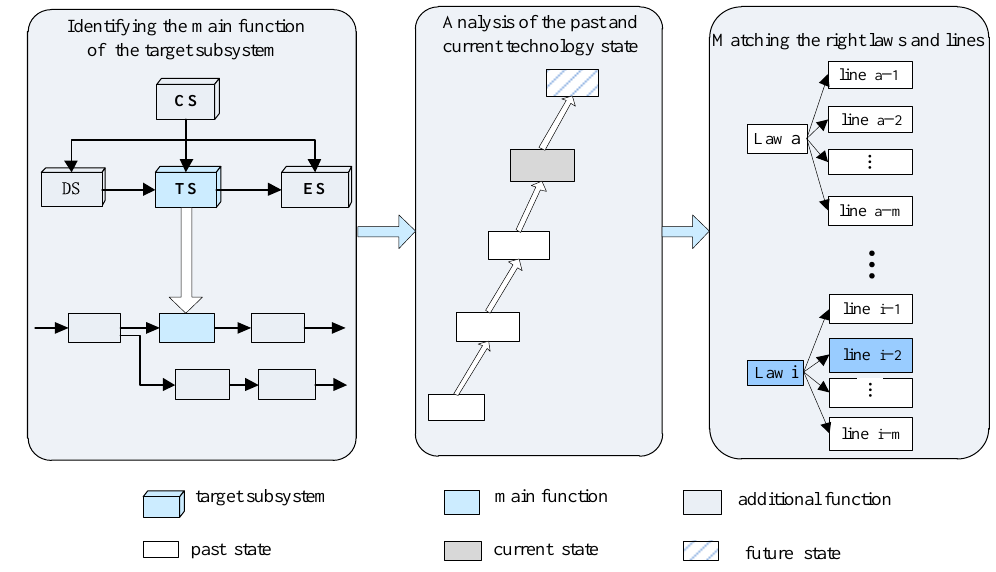
Figure 4. Determination of directions of cross-domain knowledge.